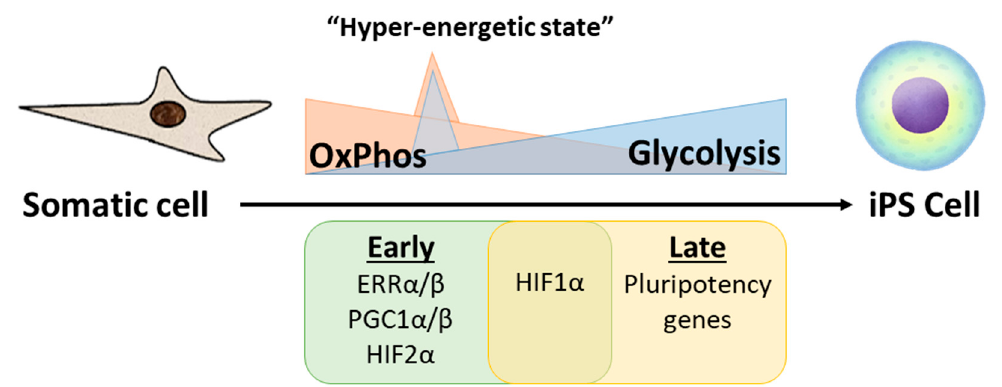
Figure 2. Somatic cell reprogramming to induced pluripotent stem cell (iPSC) involves a metabolic shift from OxPhos to glycolysis. The early expression of ERR α , ERR β , and PGC1 α / β precedes a metabolic burst leading the cells to a hyper-energetic state, which is followed by a progressive increase in glycolysis and decrease in